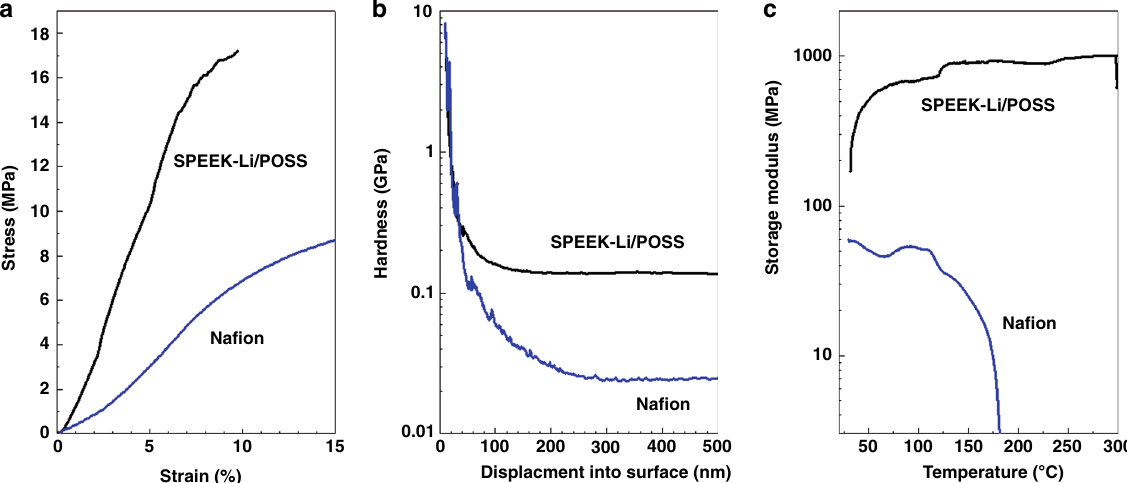
Fig. 3 Characterizations of mechanical properties. a Tensile stretch test; b nanoindentation test; c DMA test on free-standing SPEEK-Li/POSS and Na fi on ®